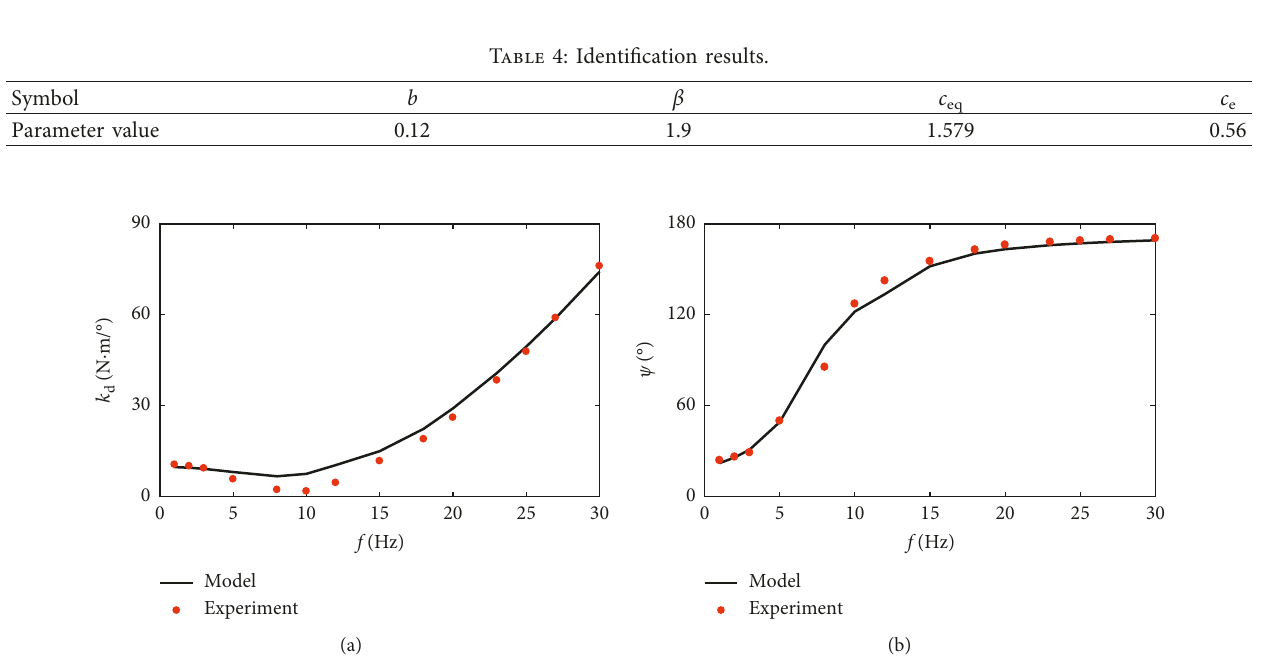
. 5 ° . (a) Dynamic stiffness k 0 (cid:31) 2